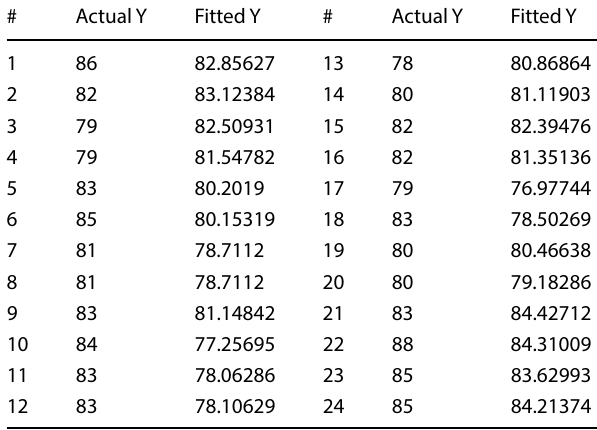
Table 9 Testing the model for the first